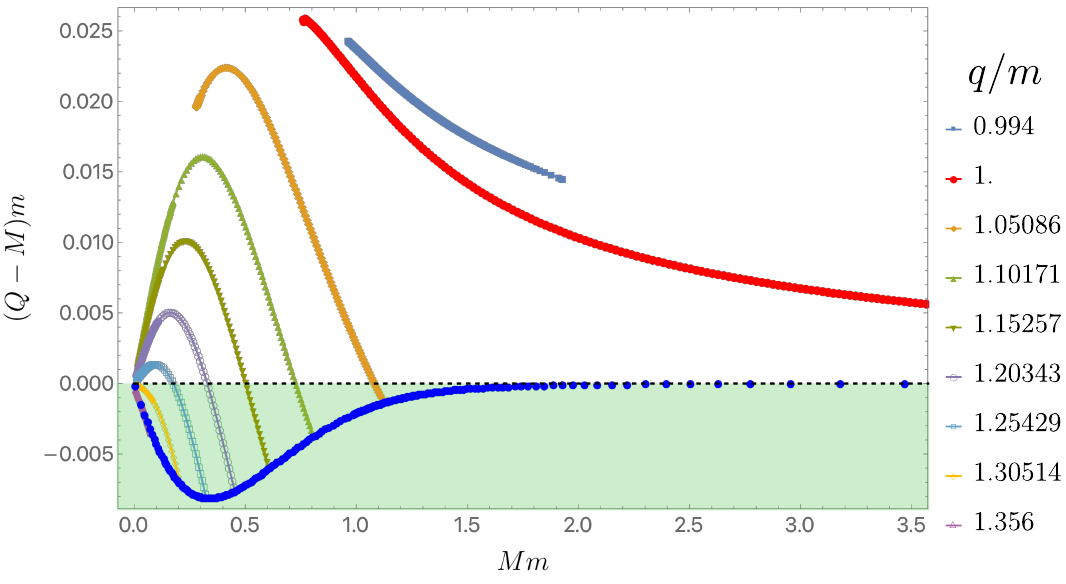
Figure 5 . Black holes with qµ = m as a function of q/m , with α = 1 . When Q > M , these are maximal warm holes. The green shaded region denotes RN black holes, and the bottom blue curve denotes the onset of their instability when qµ = m . For masses outside the range of the maximal warm holes, the extremal black hole is